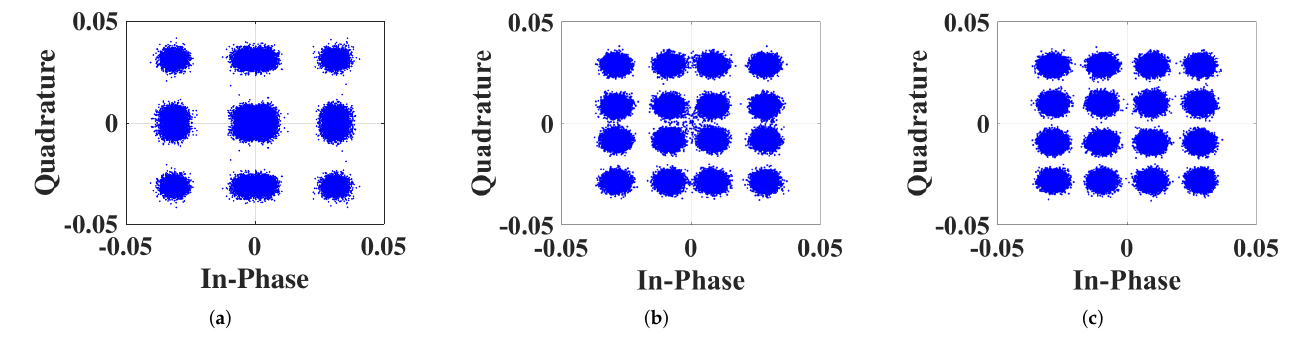
Figure 11. The SCs of the two-user NOMA VLC system obtained by experiment, when γ 1 = 18 dB. ( a ) No adjustment scheme; ( b ) SC-A scheme; ( c ) SC-SIC-A